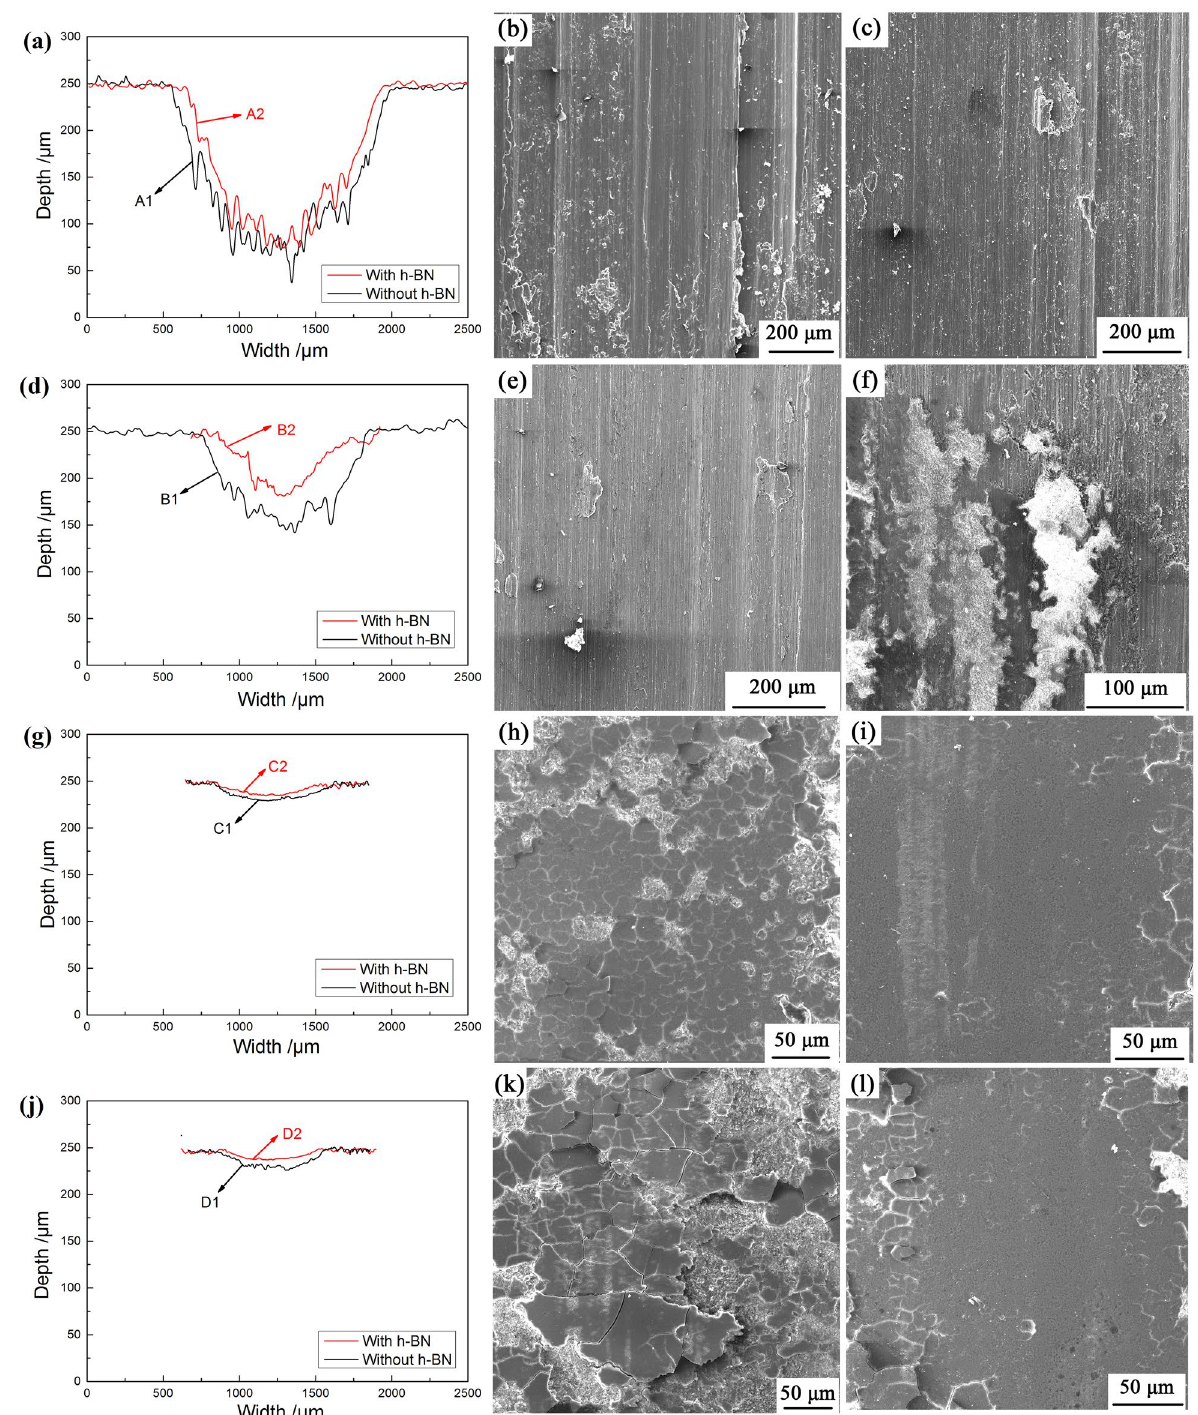
Figure 8. The 2D profiles and SEM of wear scar of the coatings. Subfigures ( a ),( b ) and ( c ) are the wear scars and the SEM of the coatings that have been oxidized for 10 min; Subfigures ( d ),( e ) and ( f ) are the wear scars and the SEM of the coatings that have been oxidized for 20 min; Subfigures ( g ),( h ) and ( i ) are the wear scars and the SEM of the coatings that have been oxidized for 30 min; and Subfigures ( j ),( k ) and ( l ) are the wear scars and the SEM of the coatings that have been oxidized for 40